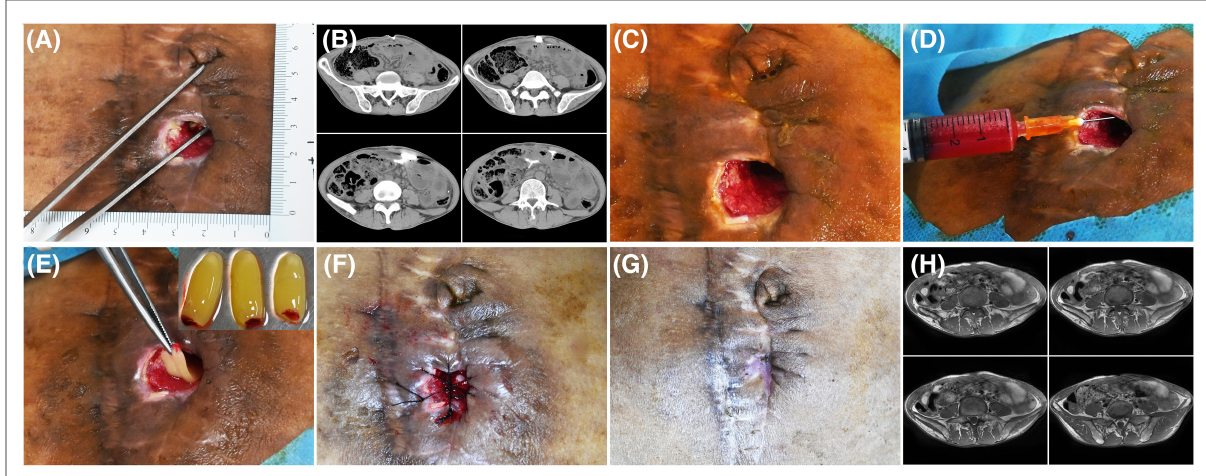
FIGURE 1 Patient 1. A 50-year-old man developed an abdominal fi stula after intestinal adhesion lysis for 2 months. ( A ) Baseline. The depth of the sinus tract was checked with sterile surgical forceps. ( B ) The enhanced computed tomography showing the abdominal fi stula. ( C ) Pre-PRP treatment. The wound was clean after debridement. ( D ) Treatment day. The wound bed was injected with PRP. ( E ) Treatment day. The fi stula was fi lled with PRF. ( F ) Treatment day. The wound was sutured with silk thread. ( G ) 14 days after the treatment. ( H ) 16 days after the treatment, MRI showing the healing of abdominal fi